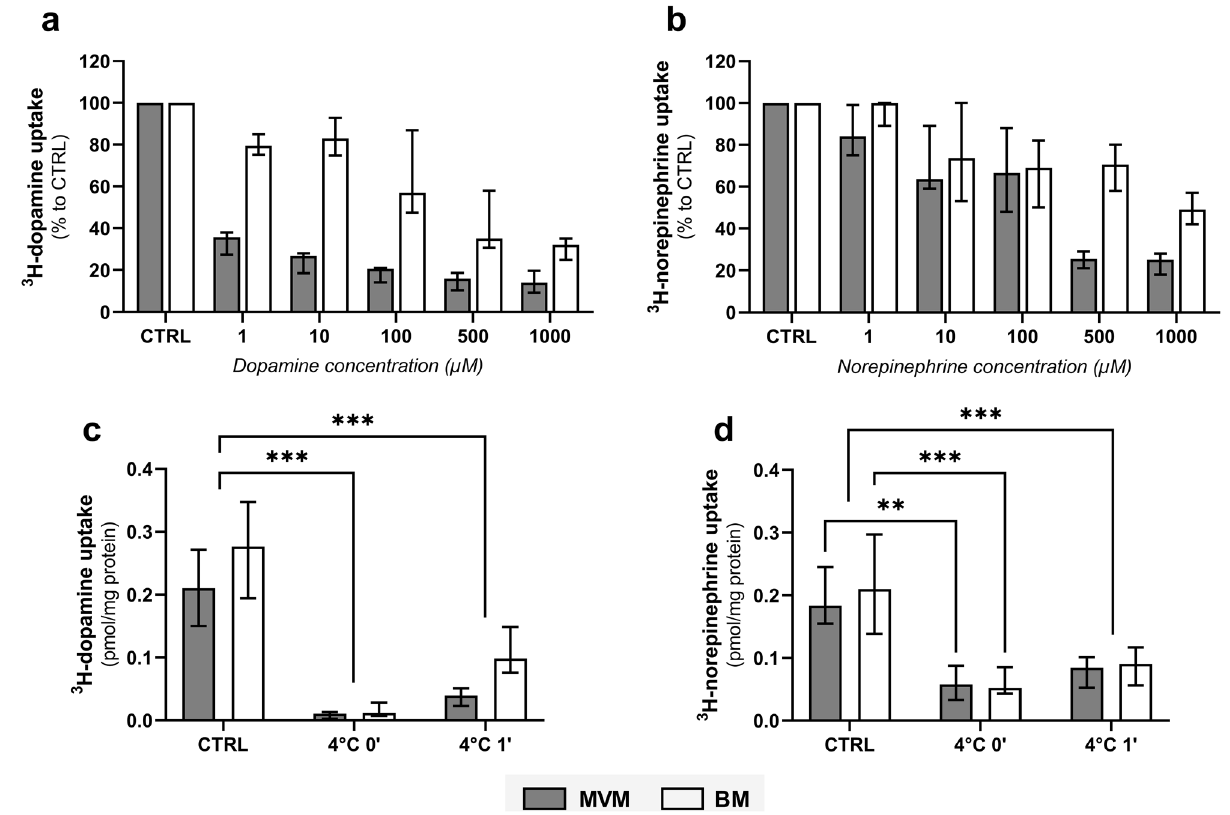
Figure 2. Characterization of 3 H-dopamine and 3 H-norepinephrine uptake kinetics into MVM and BM vesicles isolated from human term placenta. Initial uptake rates (CTRL) were determined in vesicles incubated with 112 nM 3 H-dopamine ( a , c ) and 332 nM 3 H-norepinephrine ( b , d ) at room temperature for 1 min. Concentration-dependent analysis of 3 H-dopamine ( a ) and 3 H-norepinephrine ( b ) uptakes were evaluated at a range of 1–1000 µM unlabelled substrate concentration. Subsequently, the contribution of non-specific radioisotope binding and/or passive diffusion was determined by analyzing uptake rates of 3 H-dopamine ( c )